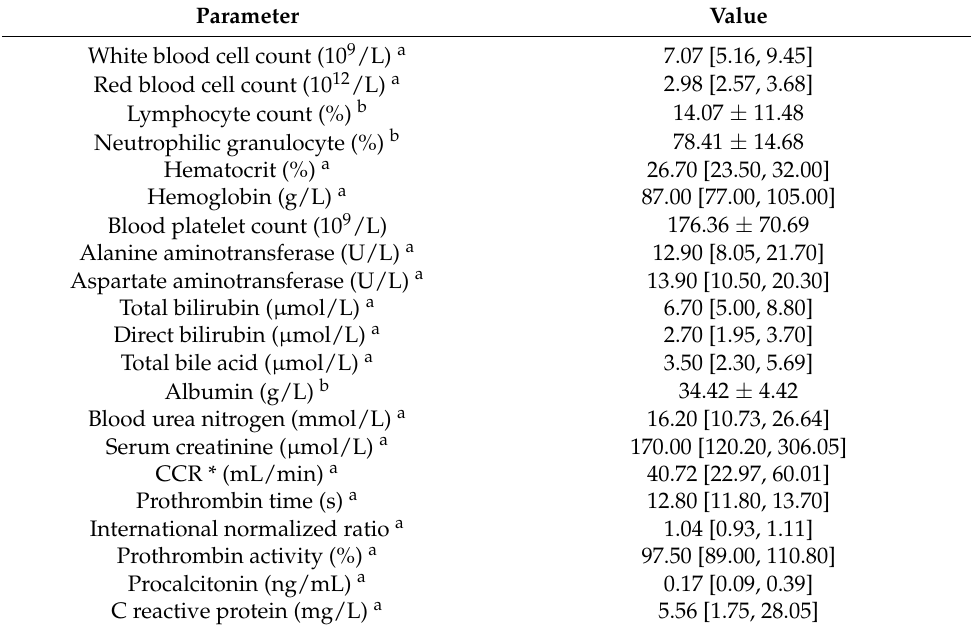
Table 3. Laboratory parameters.